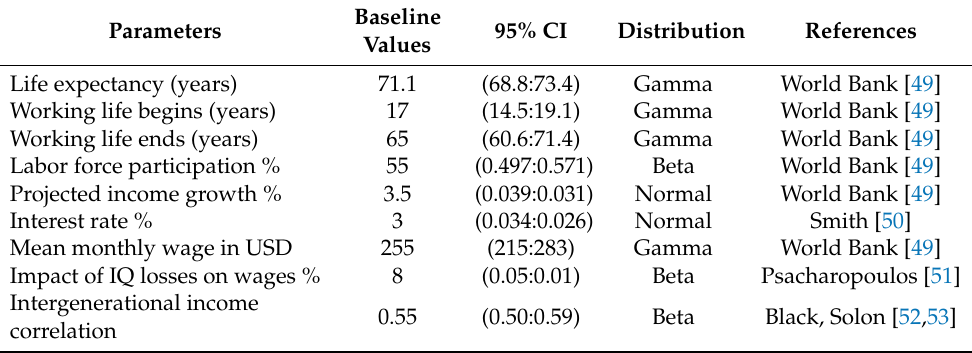
Table A3. Economic and sociodemographic parameters.